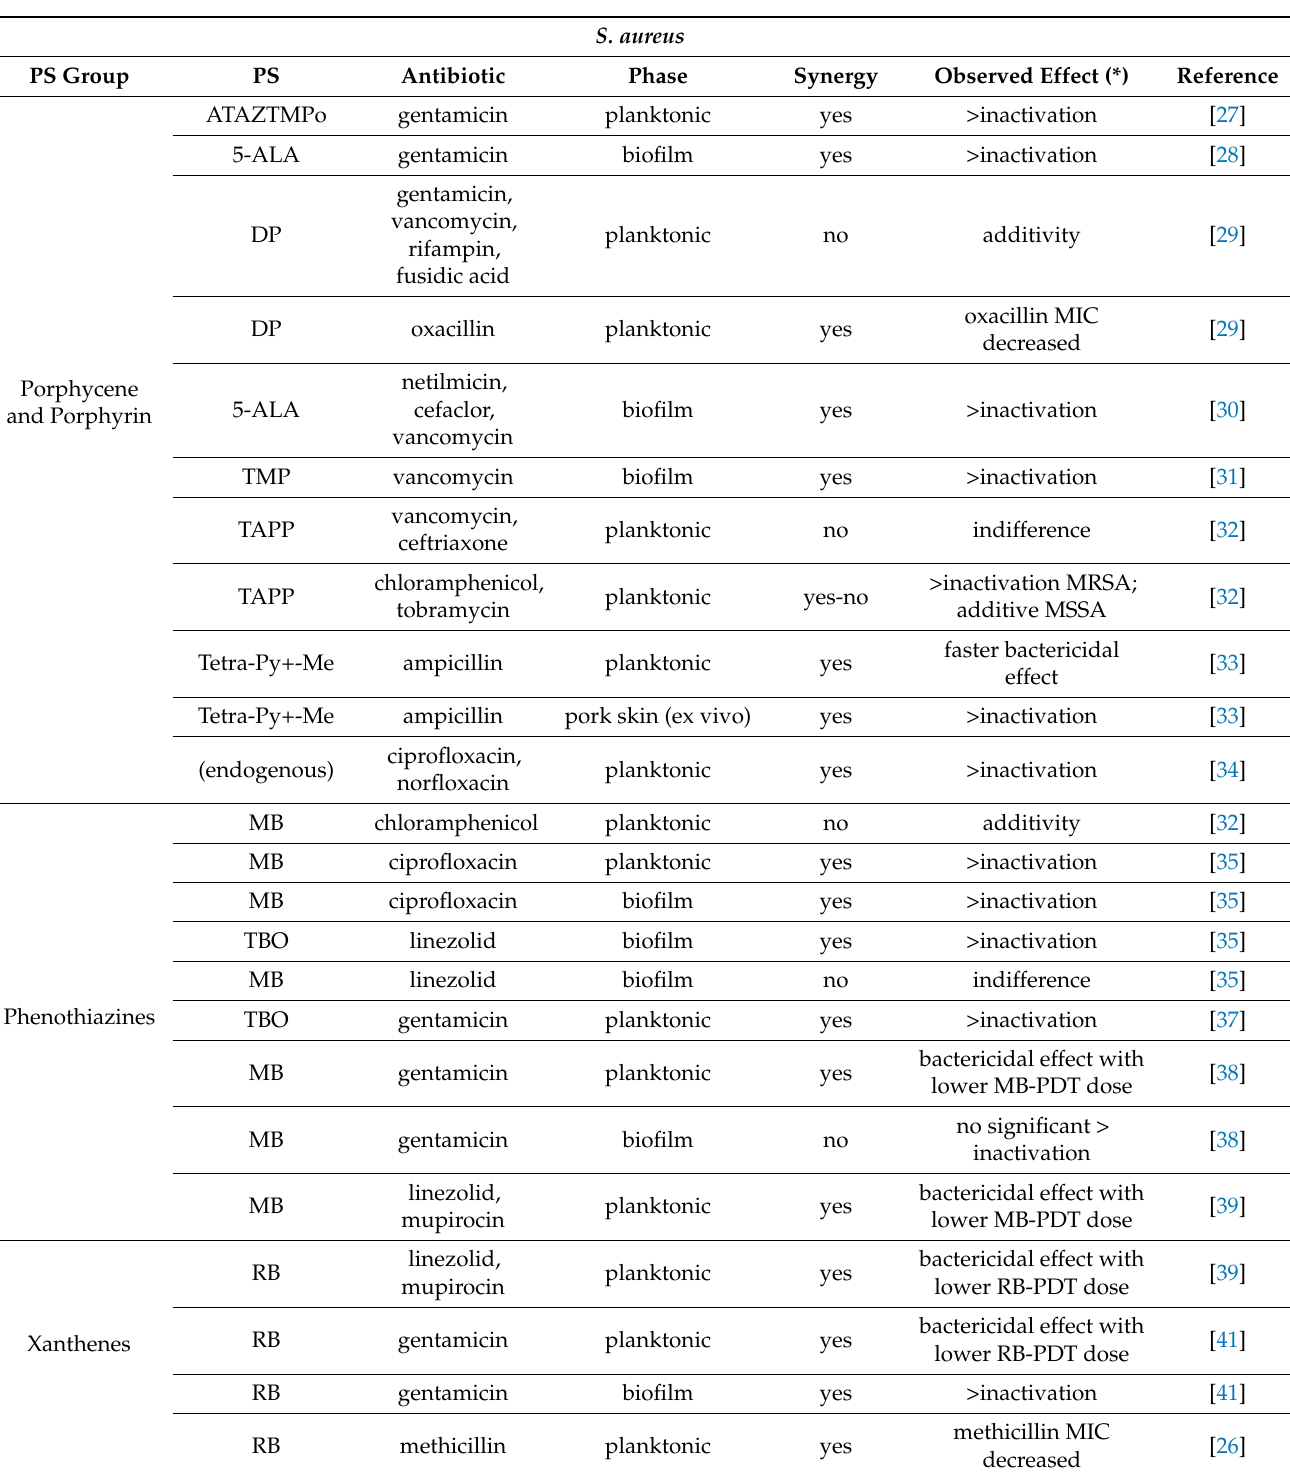
Table 5. In vitro antimicrobial photodynamic therapy plus other treatment studies on infectious microorganism of skin and soft tissues grouped by photosensitizing